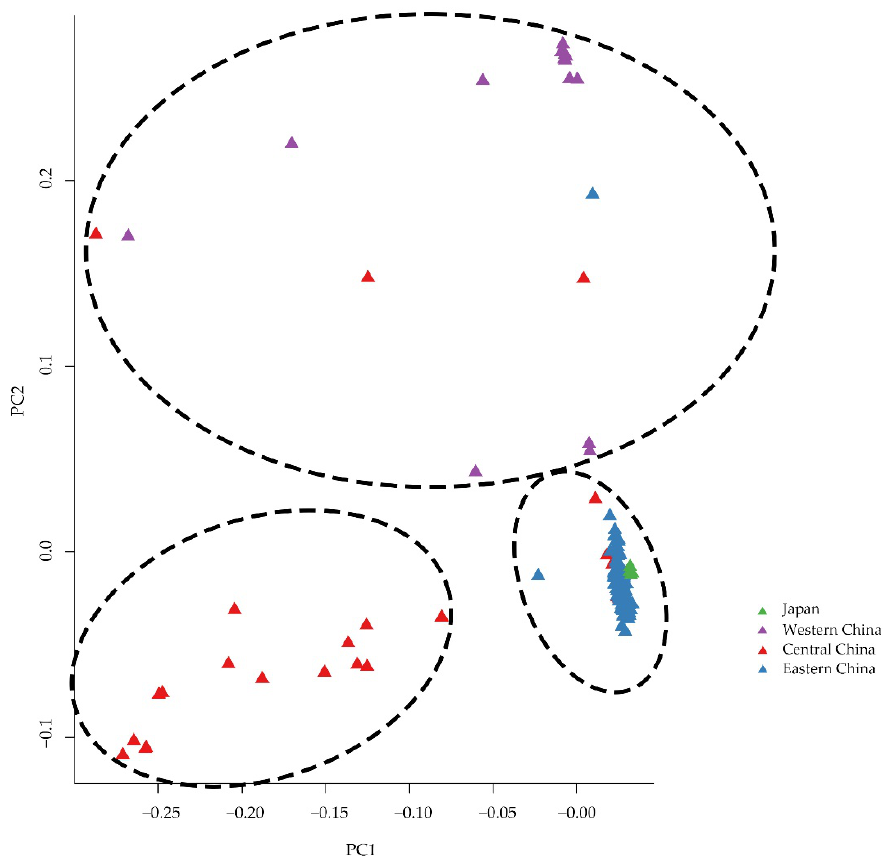
Figure 3. Population genetic structure of 171 C. camphora individuals. Each colour represents one cluster. Each individual is represented by a vertical bar, and the length of each coloured segment in each vertical bar represents the proportion contributed by ancestral populations.